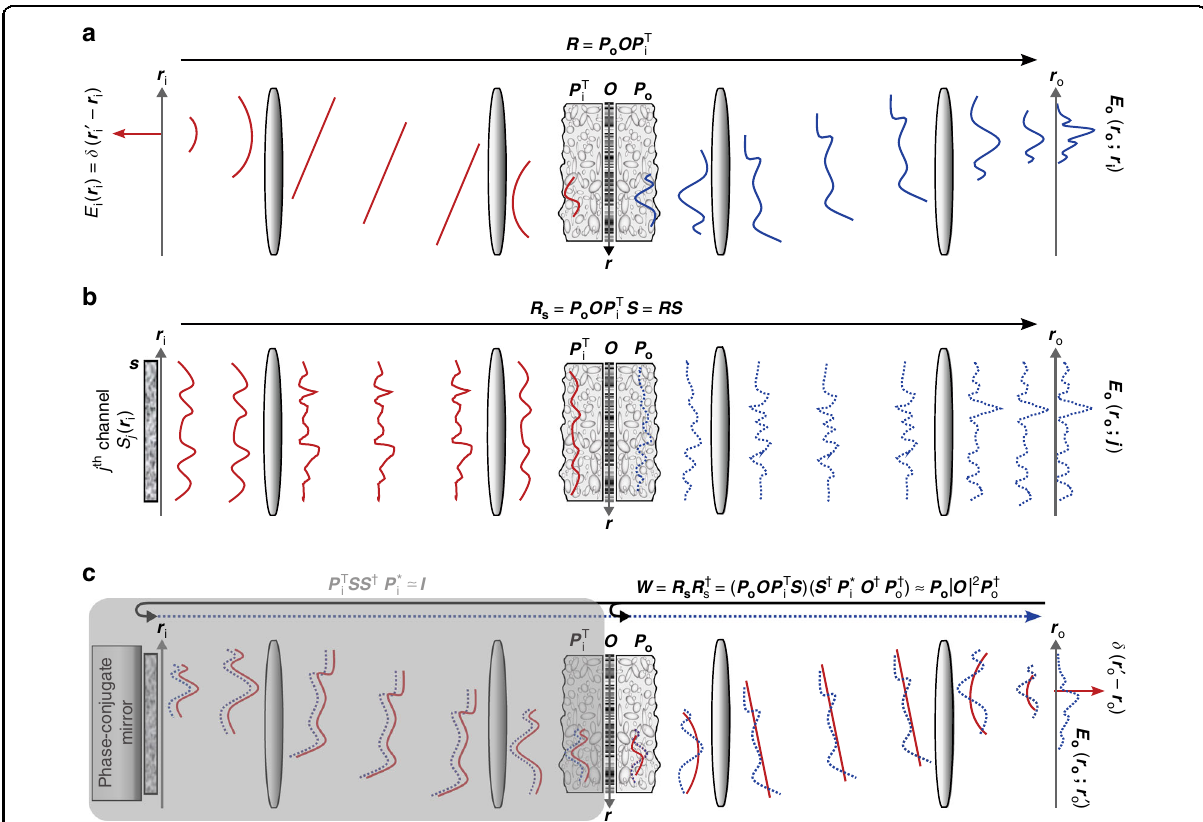
Fig. 1 Schematics of imaging geometry and time-reversal process. a Description of the re fl ection matrix R in point illumination basis. R ½ r ; r ′ E o ð r o ; r ′ is a set of E- fi eld responses E o ð r o ; r ′ to impulse input fi elds E i ð r i Þ ¼ δ ð r i (cid:2) r ′ . For clarity, the re fl ection pathway is unfolded to o i (cid:3) ¼ ½ i Þ(cid:3) i Þ i Þ the transmission side. O is the object ’ s re fl ection coef fi cient matrix, and P i ð o Þ ¼ ½ P i ð o Þ ð r ; r i ð o Þ Þ(cid:3) is the transmission matrix of the scattering medium for wave propagation from position r to r i ð o Þ . The red and blue curves represent incident and re fl ected waves, respectively. b Re fl ection matrix R S in the case of speckle illumination. R S ½ r o ; j (cid:3) ¼ ½ E o ð r o ; j Þ(cid:3) is a set of E- fi eld responses E o ð r o ; j Þ for speckle input channels S ð r i ; j Þ . R S can be written as R S = RS , where S ½ r i ; j (cid:3) ¼ ½ S ð r i ; j Þ(cid:3) is the input illumination matrix. c Geometric interpretation of the time reversal matrix. The time-reversal matrix W ½ r o ; r ′ o (cid:3) ¼ R y R can be interpreted as a re fl ection matrix describing a roundtrip process for a wave propagating from the output plane r o to the object plane r S S and re fl ecting back to the output plane by the target object | O |